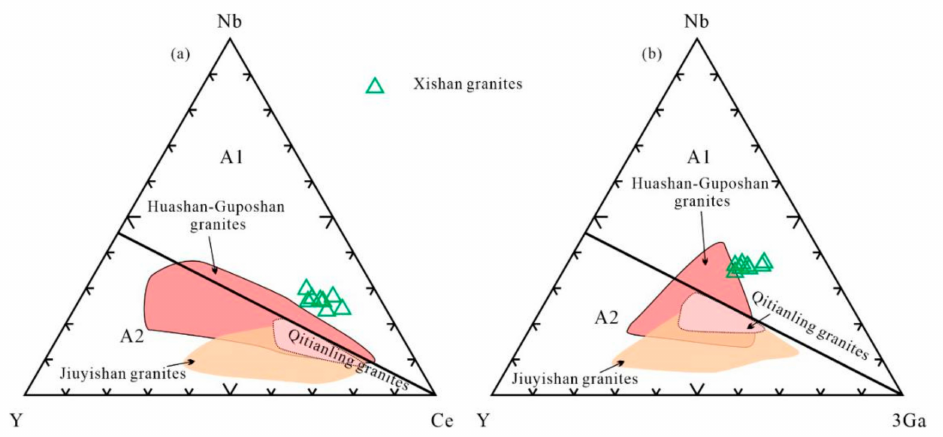
Figure 11. Discrimination diagrams of A1-type and A2-type granite for the Guiping complex (after [64]). ( a ) Nb–Ce–Y diagram; ( b ) Nb–3Ga–Y diagram. Data sources: